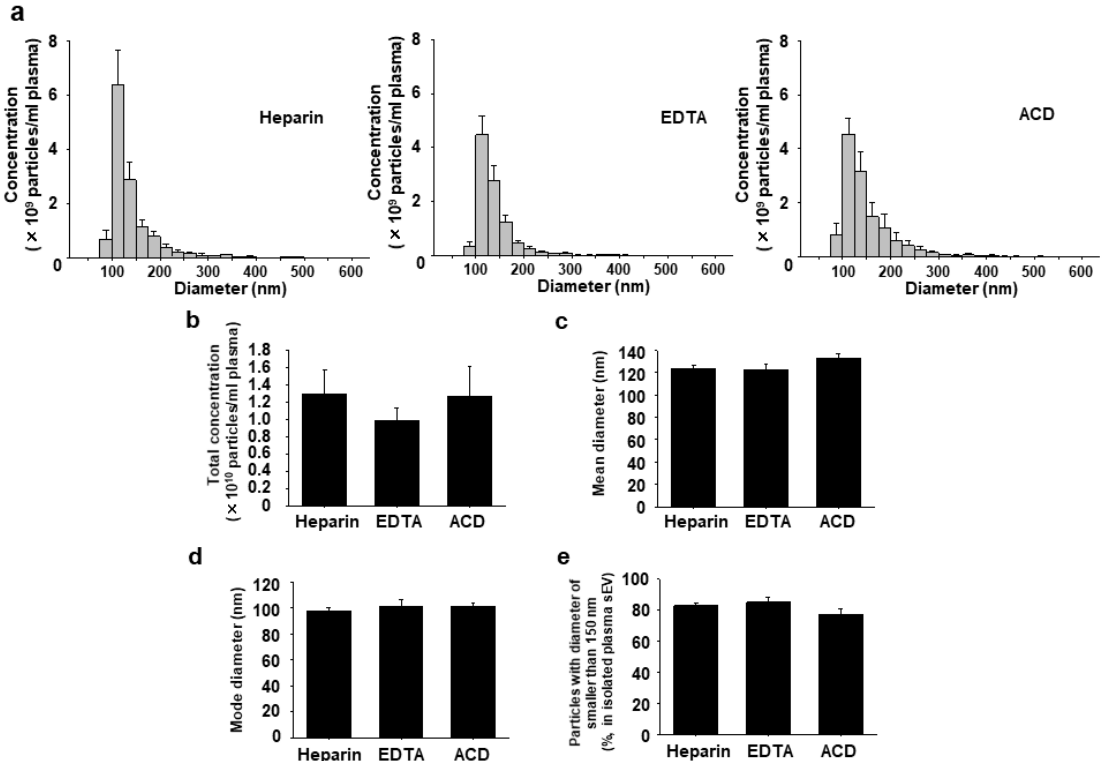
Figure 4. Effects of anticoagulants on concentration and size distribution of plasma sEVs. sEVs were isolated from heparin (1 U/mL)-, EDTA (1 mg/mL)-, or acid citrate dextrose buffer (ACD,